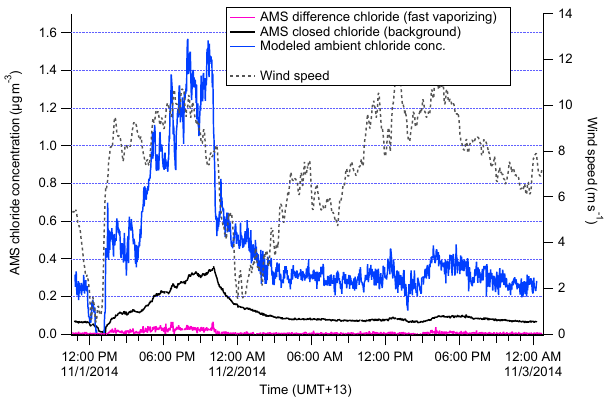
Figure 1. Measured difference (pink) and closed (black) chloride signal in AMS shown during a transition from high to low wind speed (grey). The decay of the closed signal is used to calculate the modeled ambient concentration